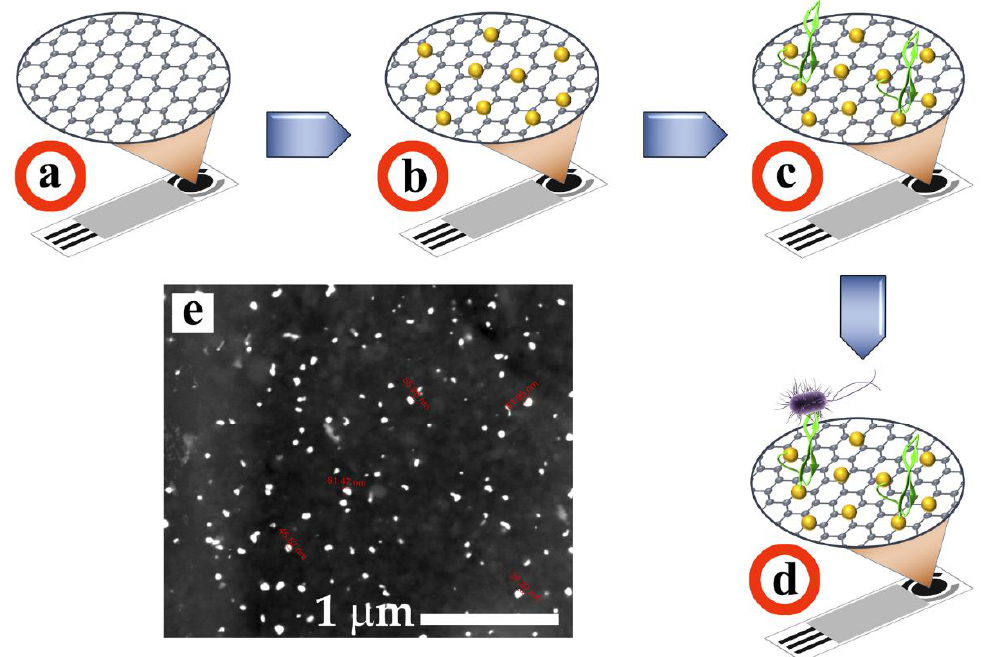
Figure 3. Schematic representation of the preparation and evaluation of the biosensors step by step. Screen-printed carbon-based electrodes ( a ) were modified with gold nanoparticles ( b ), followed by PEPTIR immobilization ( c ) and detection tests ( d ). The micrograph ( e ) was obtained in backscattered electron mode.